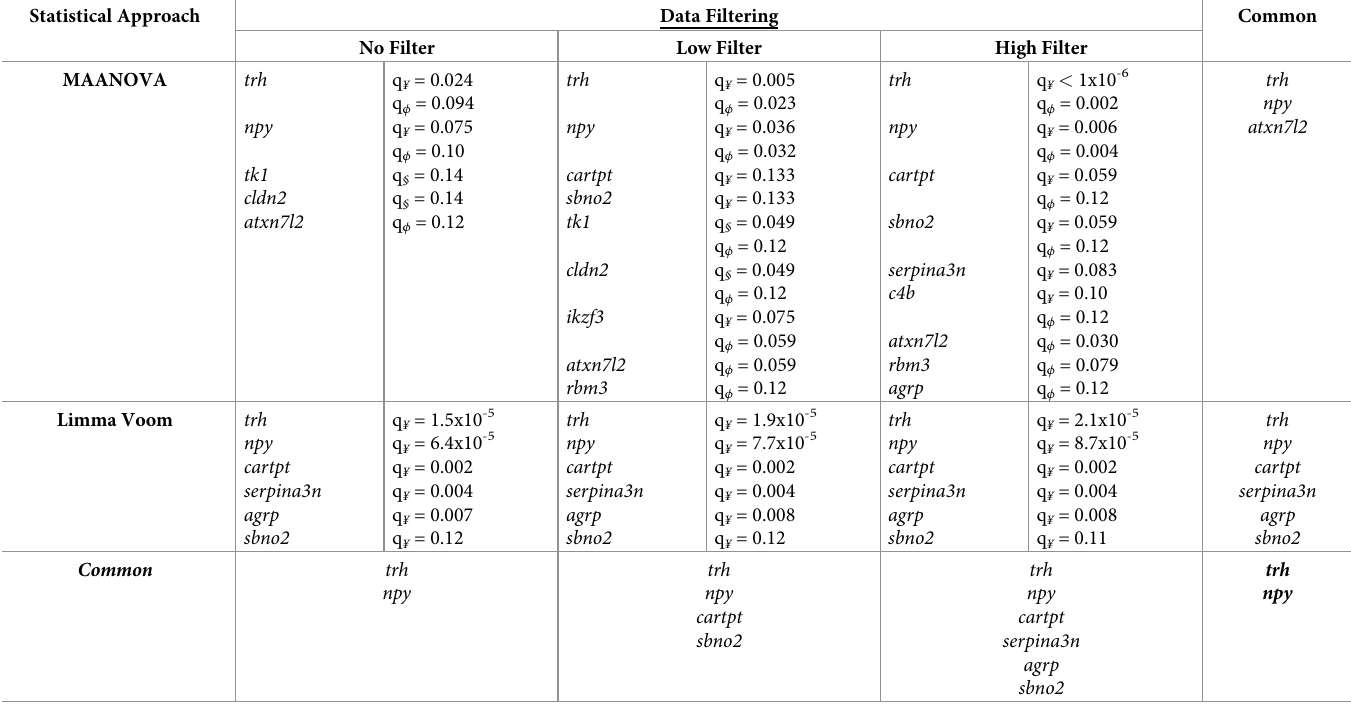
Table 2. Differentially expressed genes (DEG) from RNA-sequencing